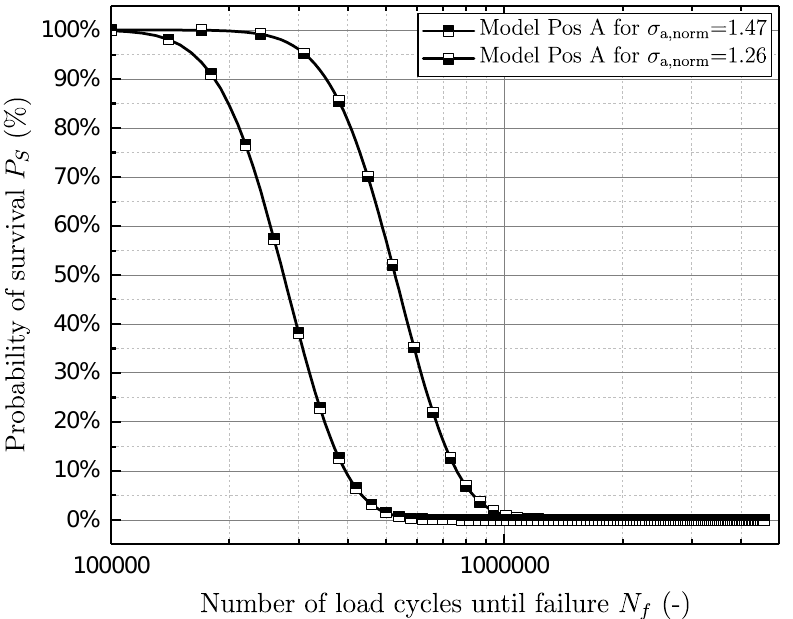
Figure 21. Validation of the model in the finite-life region position A.